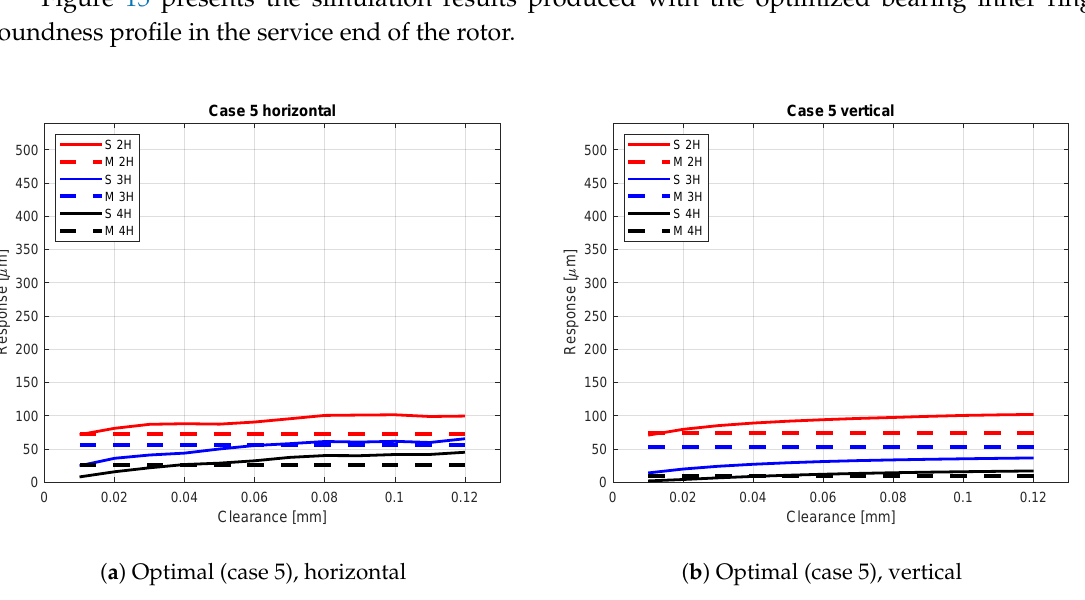
Figure 15. Case 5—minimized roundness error of the bearing inner ring in the service